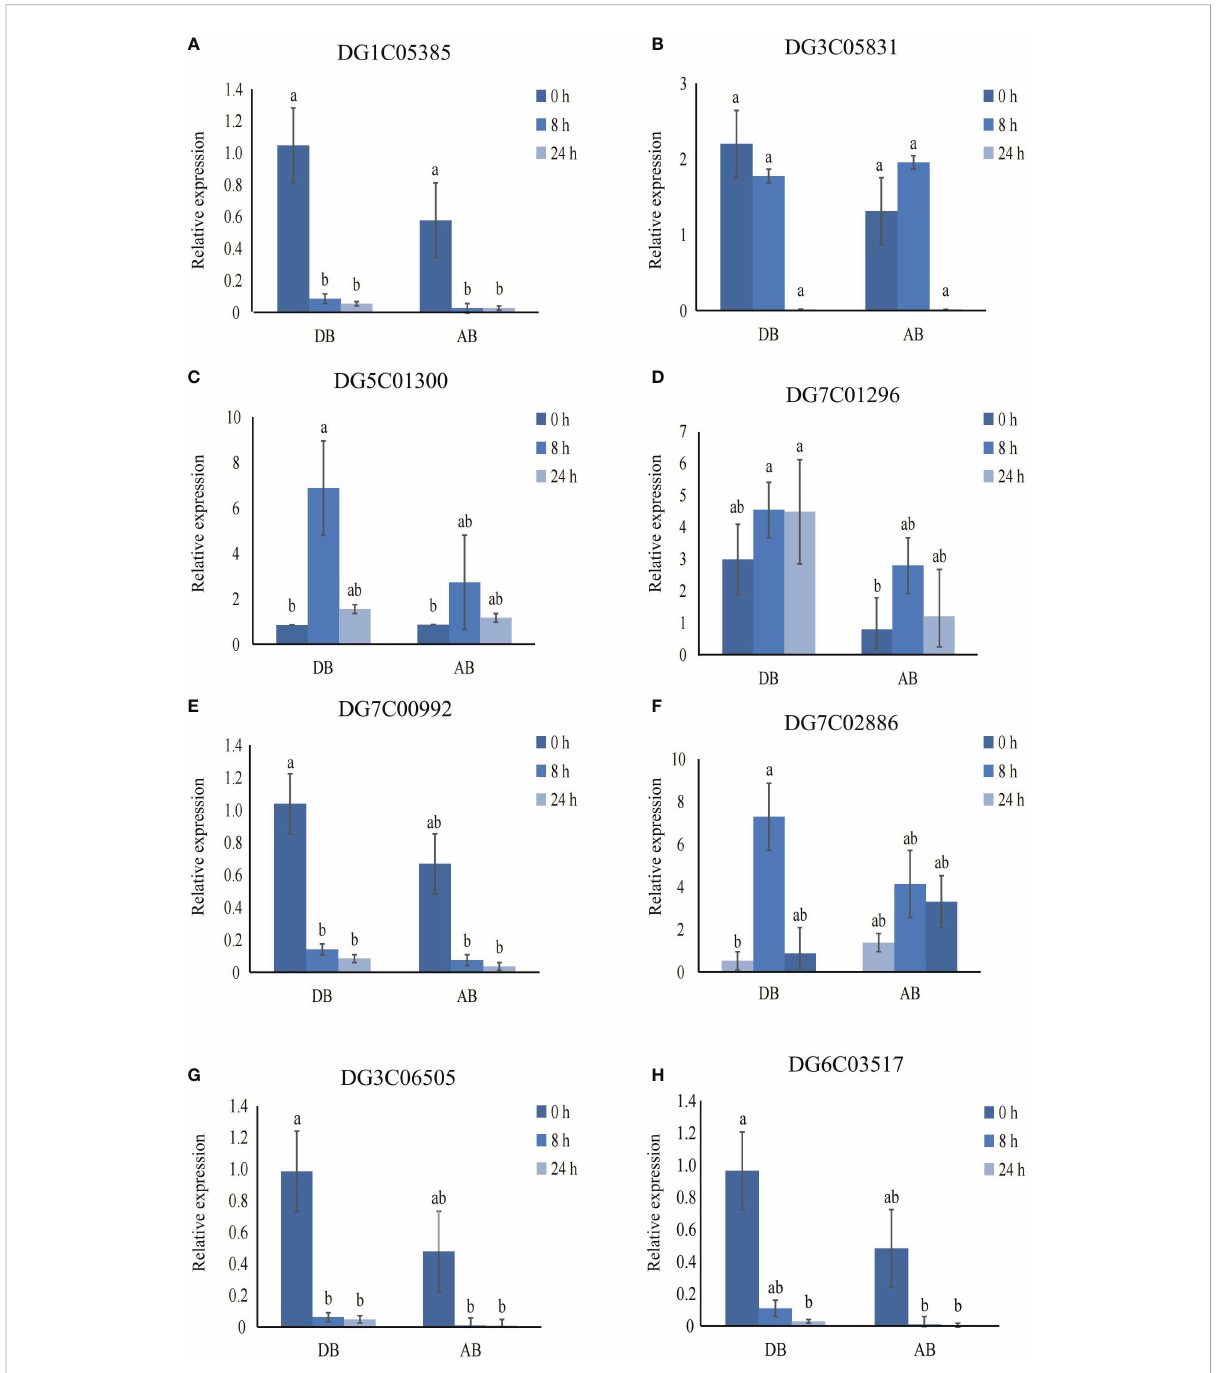
FIGURE 9 Validation of genes expression using qRT-PCR. (A) DG1C05385. (B) DG3C05831. (C) DG5C01300. (D) DG7C01296. (E) DG7C00992. (F) DG7C02886. (G) DG3C06505. (H) DG6C03517. Error bars indicate the standard error, n = 3. Different letters indicate the signi fi cant differences. Statistical analysis using one-way analysis of variance (ANOVA) using Duncan ’ s multiple range test ( P <